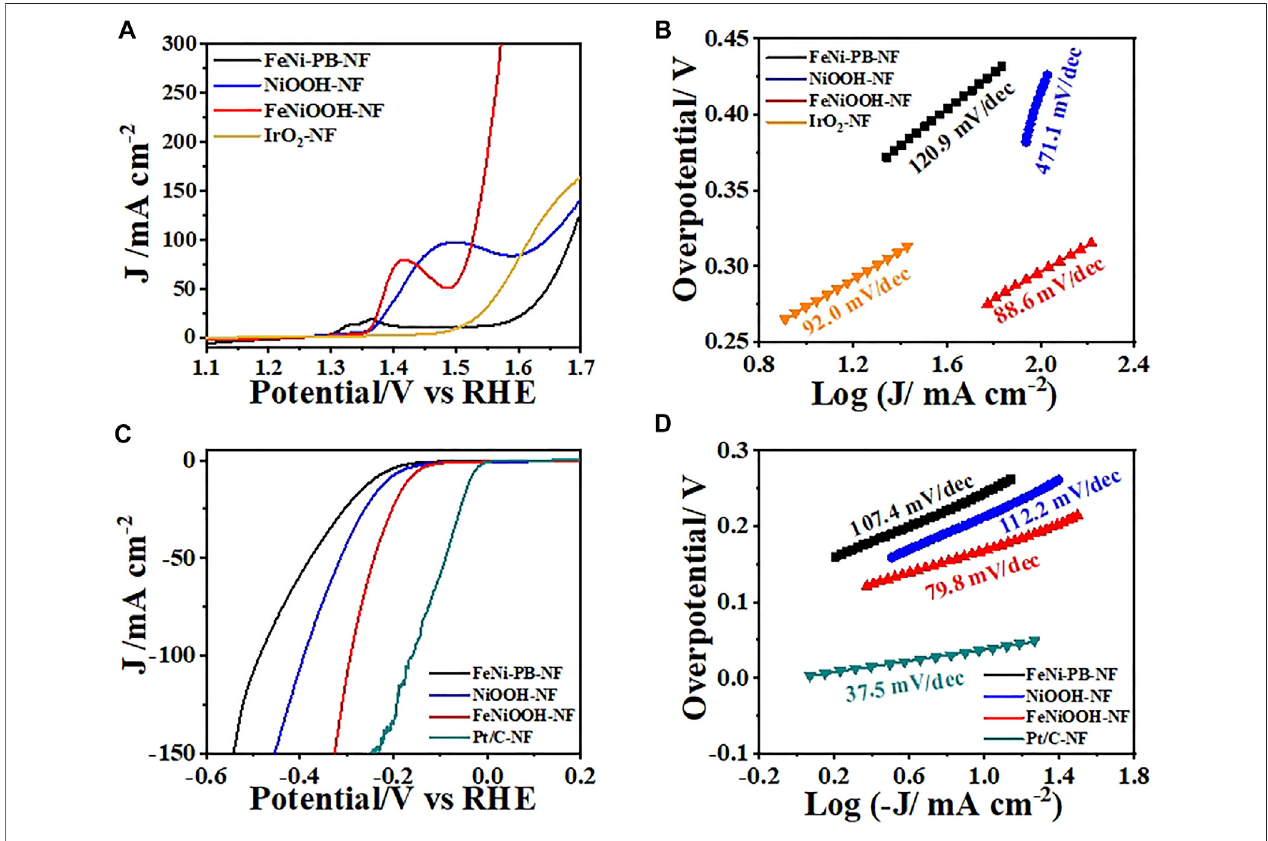
FIGURE 4 | (A) LSVs and (B) Tafel plots of FeNi-PB-NF, NiOOH-NF, FeNiOOH-NF and IrO2-NF for OER. (C) LSVs and (D) Tafel plots ofFeNi-PB-NF, NiOOH-NF, FeNiOOH-NF, and IrO 2 -NF for HER.